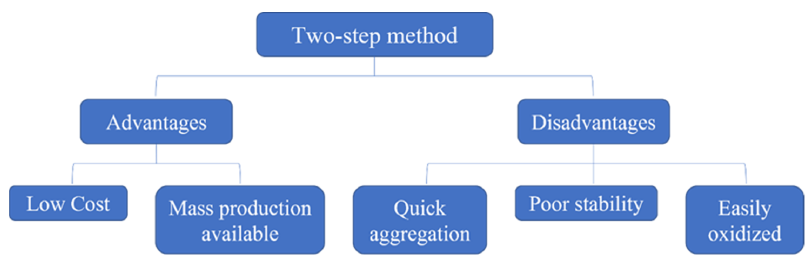
Figure 2. Advantages and disadvantages of the two-step method.